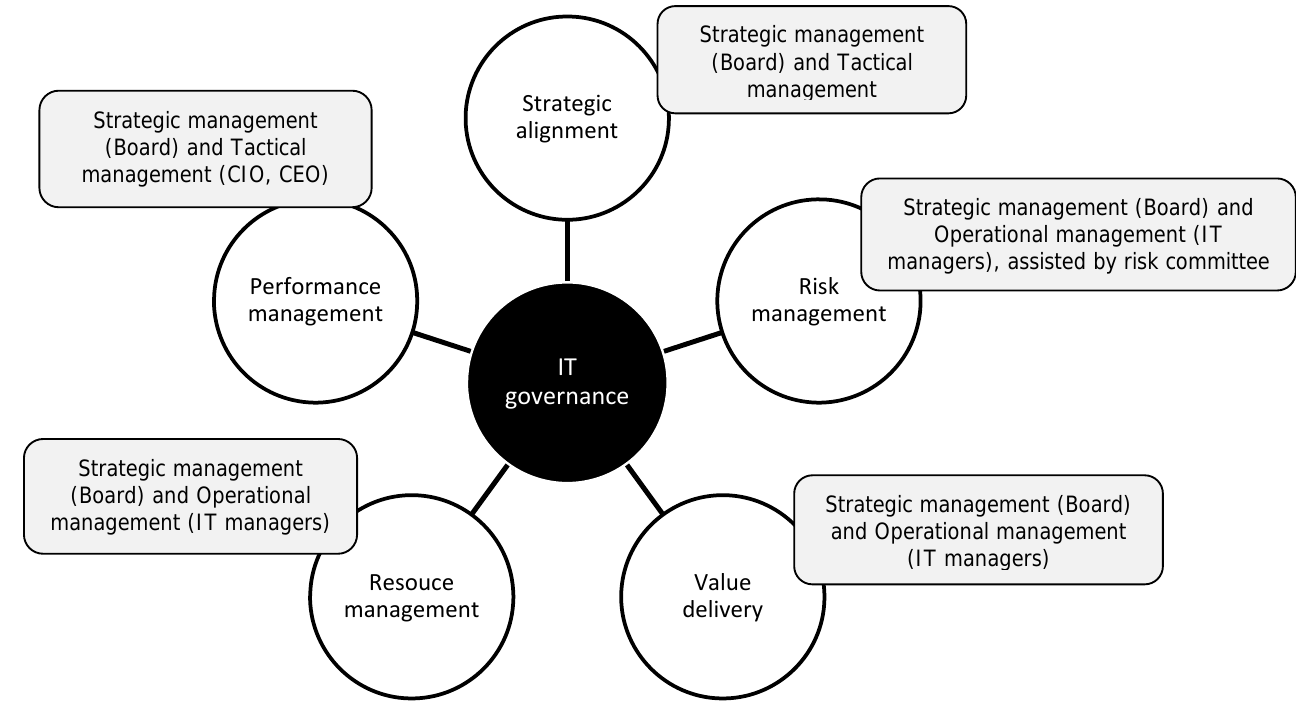
Figure 4: Management levels and ITG focus